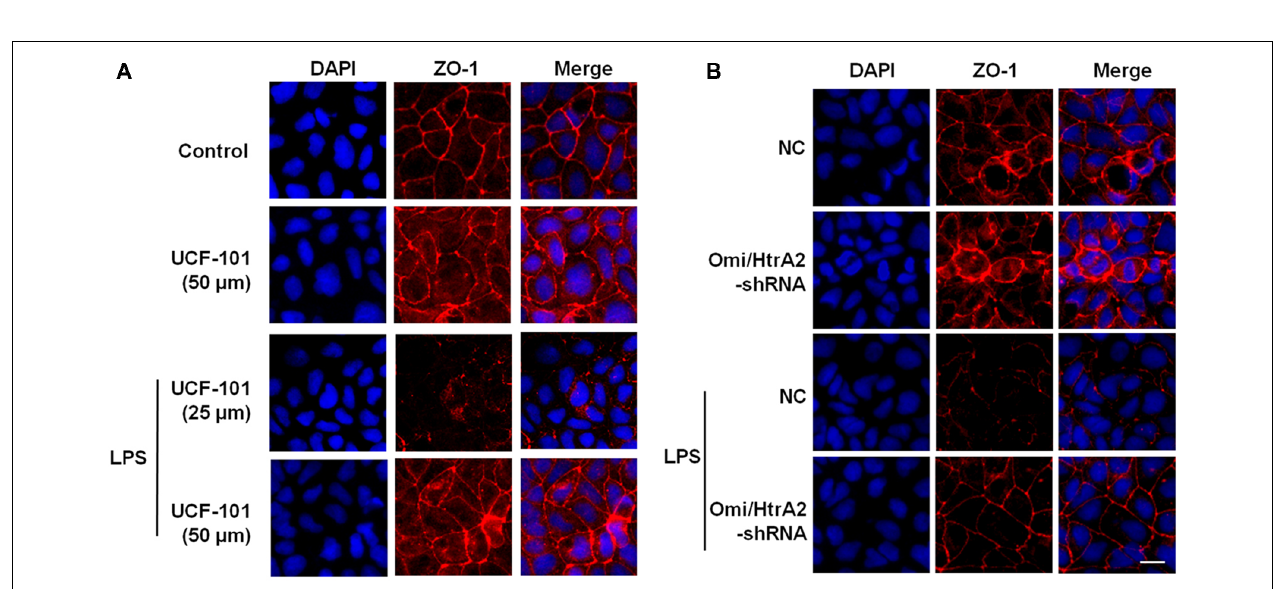
FIGURE 6 | Effects of abrogation of Omi/HtrA2 by UCF-101 (A) or Omi/HtrA2 shRNA (B) on TJ protein ZO-1 expression in LPS-treated hCMEC/D3 monolayers as determined by immunofluorescence. Red staining show TJ. Nucleus (blue) was labeled with DAPI. Scale bar, 25 µ m.